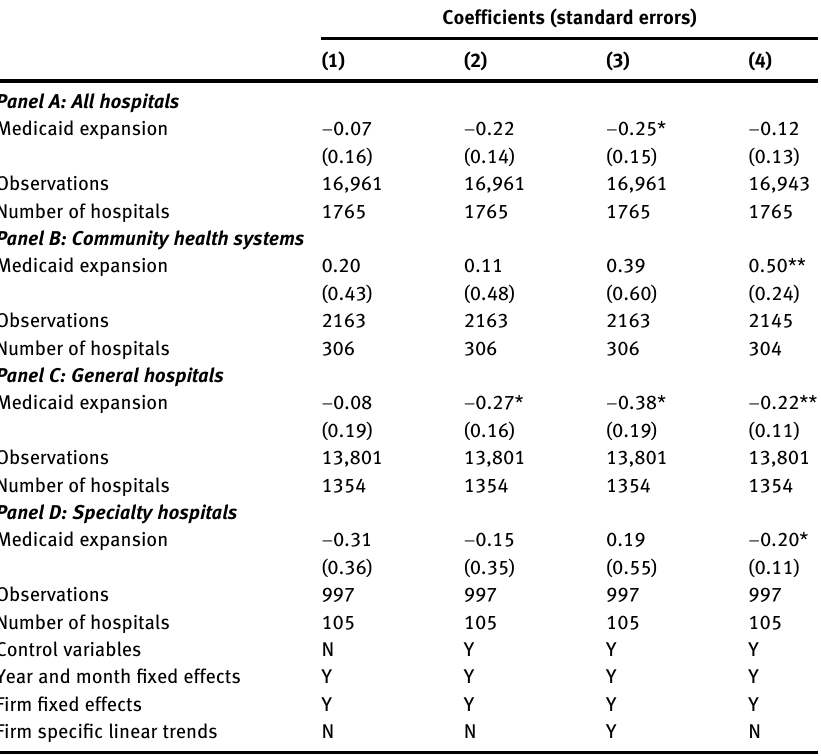
Table  : The impacts of Medicaid expansion on nonpro fi t hospitals contributions by